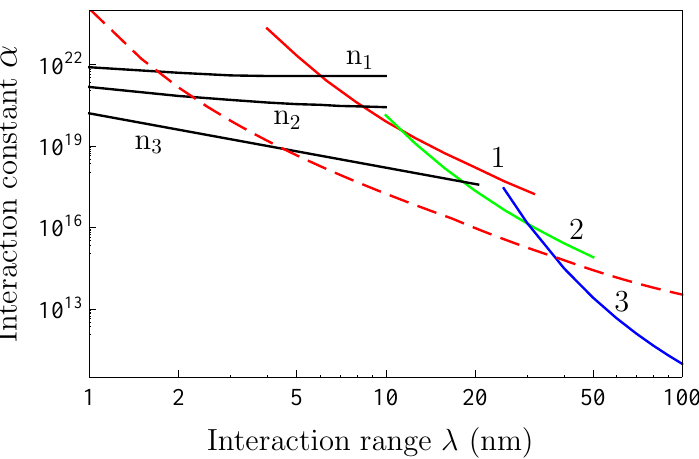
Figure 2. The constraints on the parameters of the Yukawa-type interaction, which can be obtained from the optimized experiment on measuring the lateral Casimir forces between the sinusoidally corrugated surfaces are shown by the dashed line. The lines labeled n 1 [17], n 2 [16] and n 3 [18] show the constraints following from the experiments on neutron scattering. The lines labeled 1, 2 and 3 show the constraints following from measurements of the lateral [35–37] and normal [38–40] Casimir forces between corrugated surfaces and from the differential measurements [30]. The regions of the ( λ , α )-plane above each line are excluded and below each line are